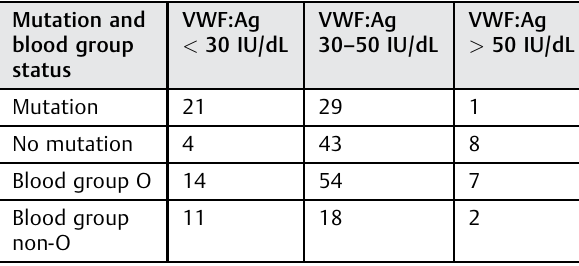
Abbreviations: VWD, von Willebrand disease; VWF:Ag, von Willebrand factor